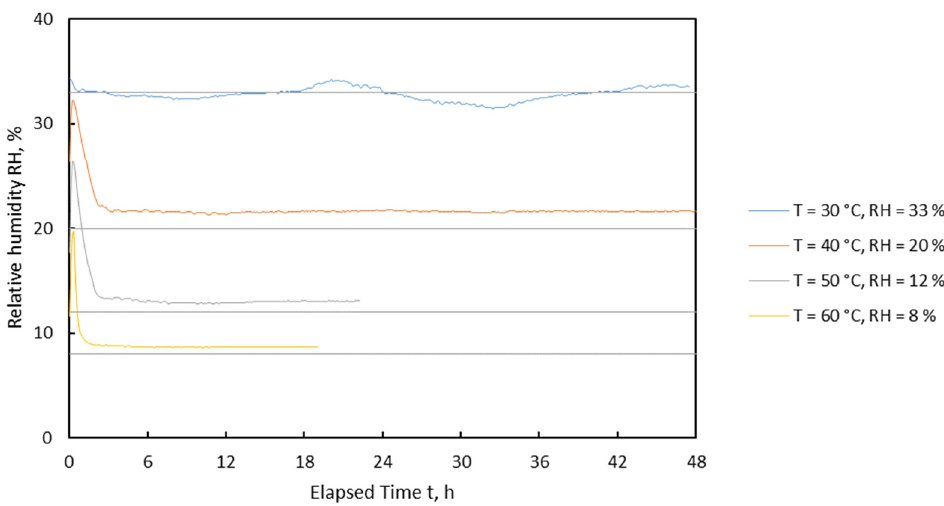
Figure 9. Relative humidity vs. time; relative humidity during drying of fresh nettles at different levels of set air temperature (T set ) in the HPD TP3+; x set = 0.01, v set = 0.2 m · s − 1 . Based on the measured T and RH, the actual water content (x calc ) of the drying air was calculated based on Equation (3):